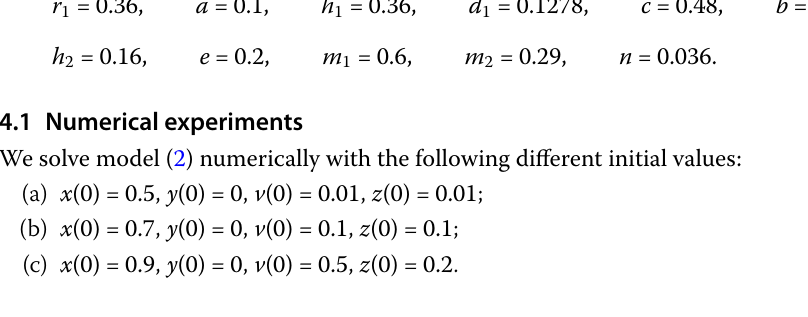
Table 1 The model parameters, their description and values Parameter Description Value Units